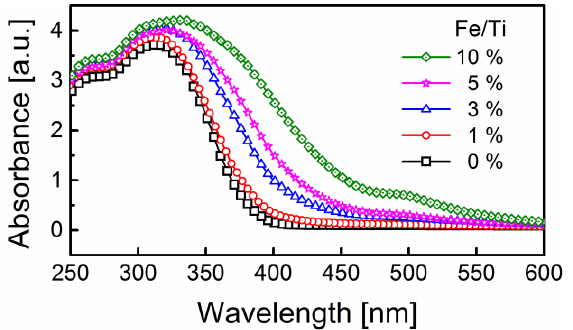
Figure 14. Ultraviolet–visible (UV–vis) spectra for iron-free and iron-doped TiO 2 nanoparticles.